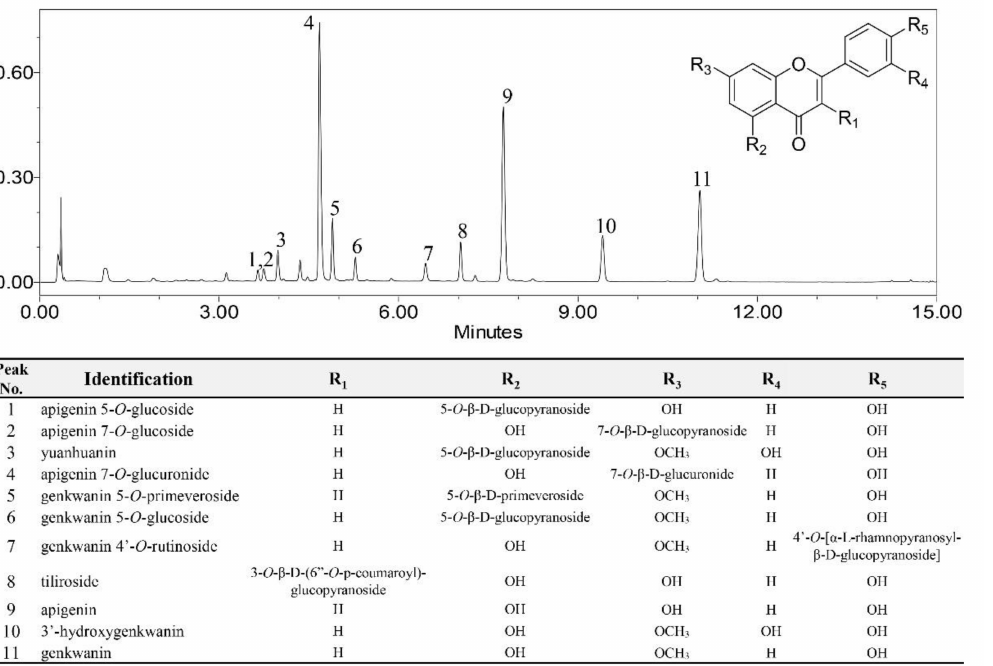
Figure 2. Representative UHPLC chromatogram of D. genkwa buds in 56% ( v / v ) acetone solvent. Flavonoids are indicated in the figure as 1–11: (1) apigenin 5- O -glucoside, (2) apigenin 7- O -glucoside, (3) yuanhuanin, (4) apigenin 7- O -glucuronide, (5) genkwanin 5- O -primeveroside, (6) genkwanin 5- O -glucoside, (7) genkwanin 4 (cid:48) - O -rutinoside, (8) tiliroside, (9) apigenin, (10) 3 (cid:48) -hydroxygenkwanin, and (11)